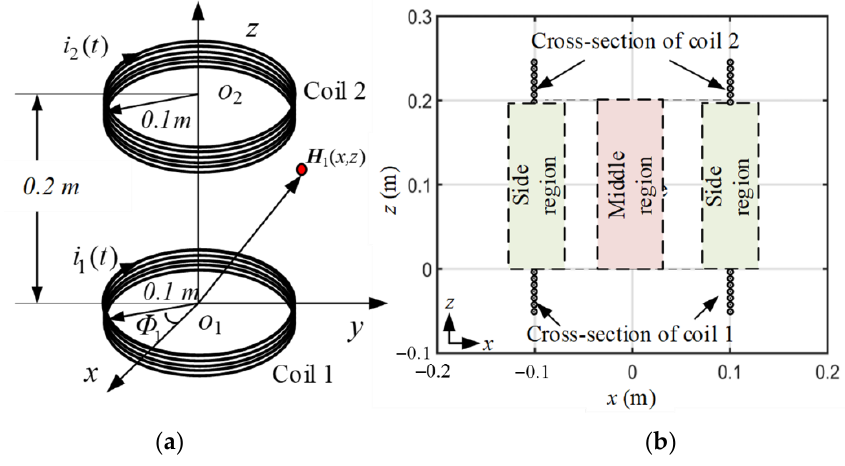
Figure 1. Two-coil WPT system. ( a ) the position of the two-coil WPT system. ( b ) the cross-section on the xoz plane of the WPT system.